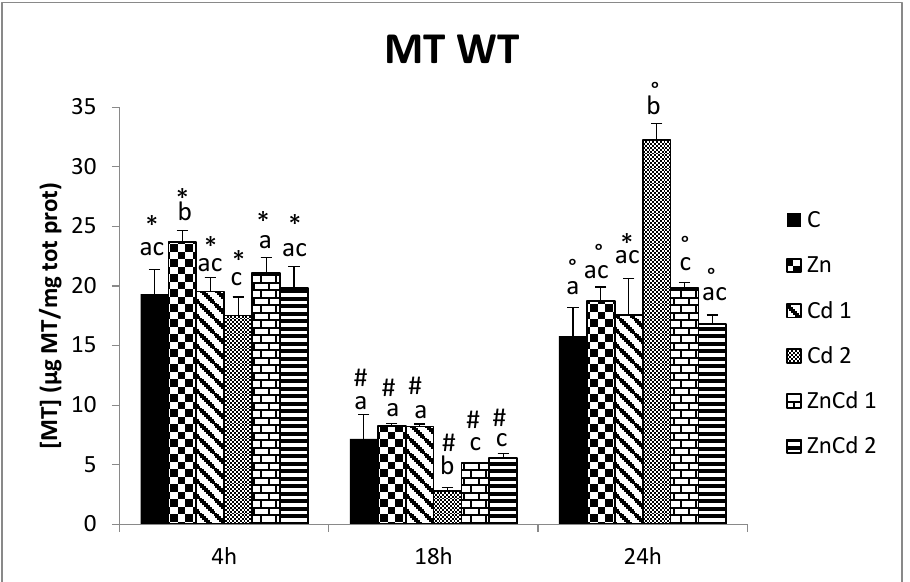
Figure 4. MT content in µg/mg protein versus time in the WT strain. Different letters indicate statistically significant differences between the various treatments of the same time, while the symbols indicate statistically significant differences between times within the same treatment. C = Control; Zn = Zn 50 µM; Cd 1 = Cd 1 µM; Cd 2 = Cd 2 µM; ZnCd 1 = Zn 50 µM + Cd 1 µM; ZnCd 2 = Zn 50 µM + Cd 2 µM.